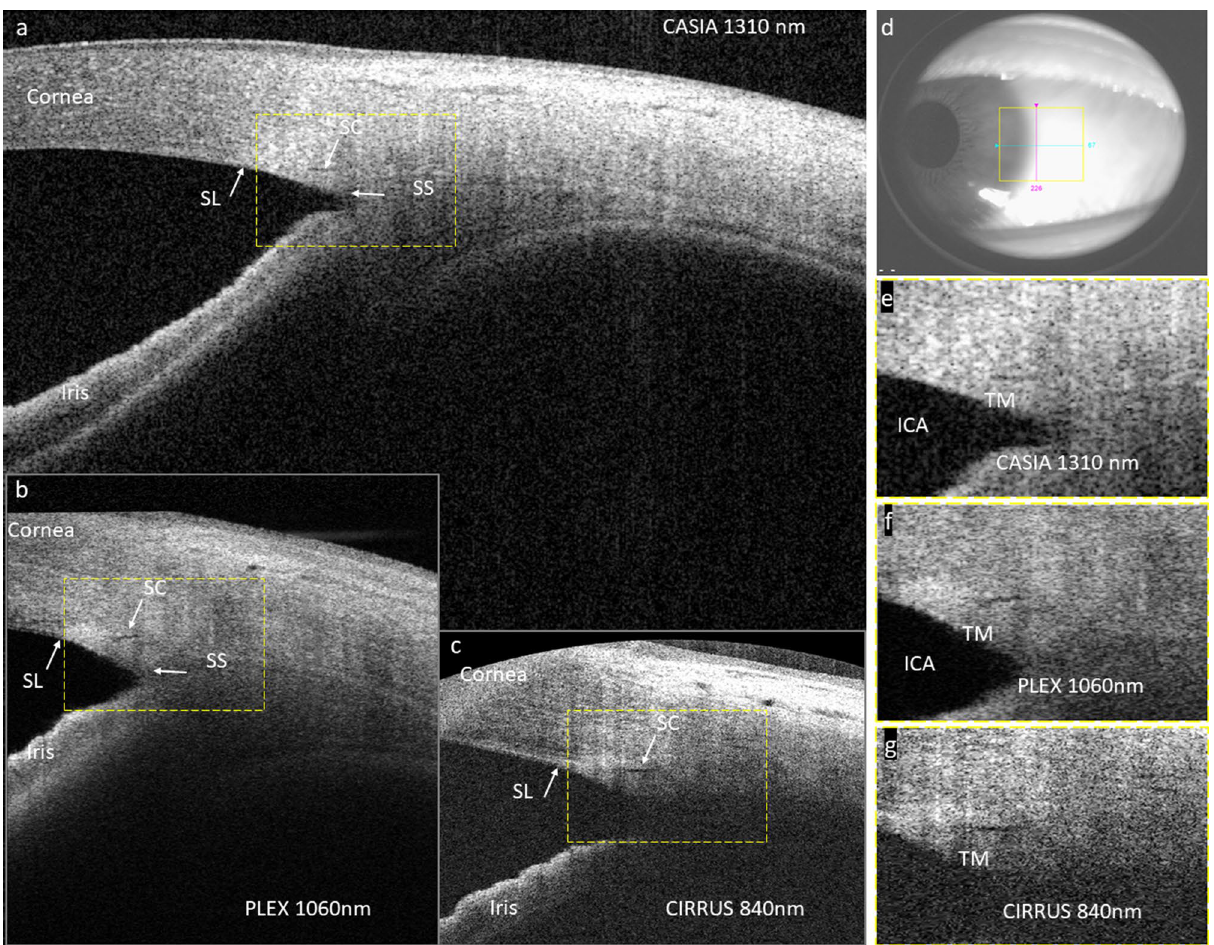
Figure 1. ( a )–( c ) Selected OCT B-scans of SC obtained by CASIA, PLEX, and CIRRUS, respectively, taken at the same quadrant of the same eye. The regions-of-interest (ROIs) of Schlemm’s canal are marked by yellow dashed rectangles. ( d ) White-light camera image showing the acquisition location. ( e )–( g ) Zoom-in views of the SC ROIs in CASIA, PLEX, and CIRRUS images, respectively. ICA: iridocorneal angle; SC: Schlemm’s canal; SL: Schwalbe’s line; SS: scleral spur; TM: trabecular meshwork.